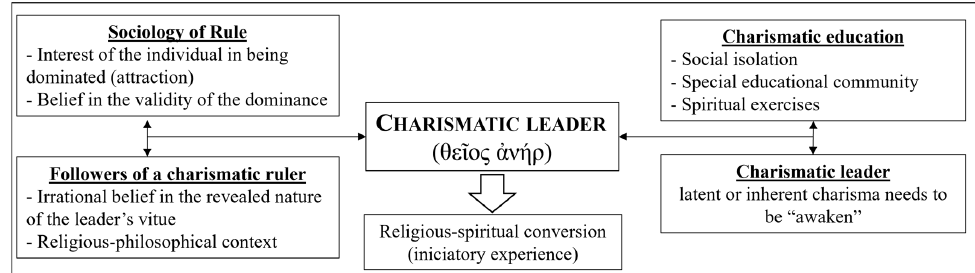
Figure 1. Weber’s theory of charisma (Alviz Fernández 2022, Figure 1, slightly modified detail).